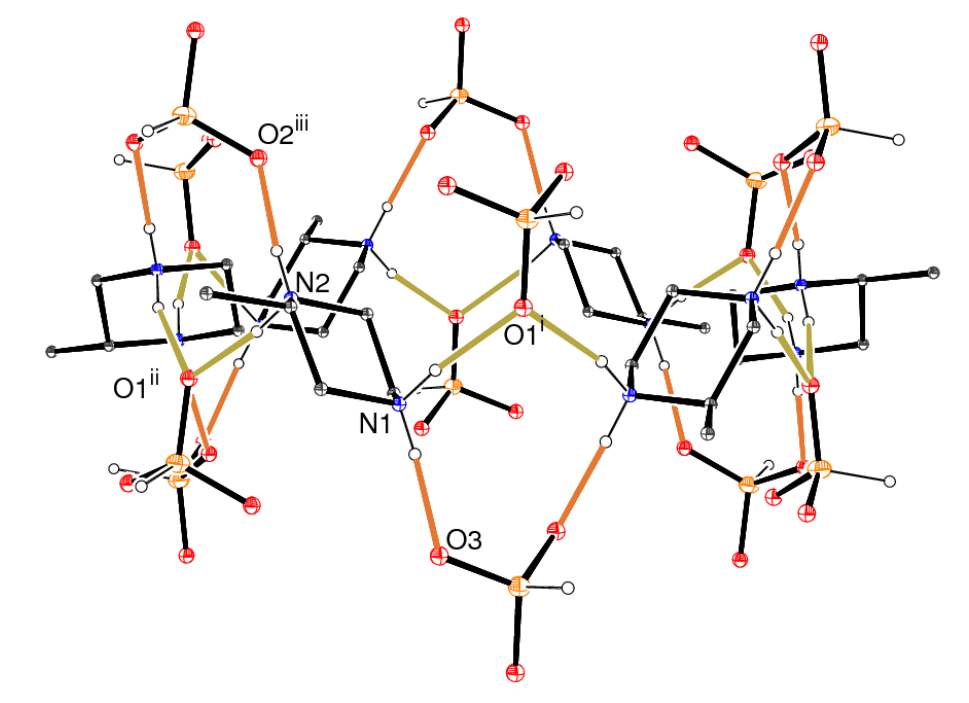
Figure 5. A slice of a “supramolecular wrapper” of hydrogen bonded cations and anions in 2 , viewed approximately normal to the c axis direction. Hydrogen bonds to the µ 2 -bridging O1 atom and µ 1 + µ 1 O2+O3 atoms are shown as brass and mandarin lines, respectively. The C-bound H atoms are omitted for clarity. The most direct transit about the wrapper generates an R 6 (42) loop [5]. See Table 2 for symmetry 12